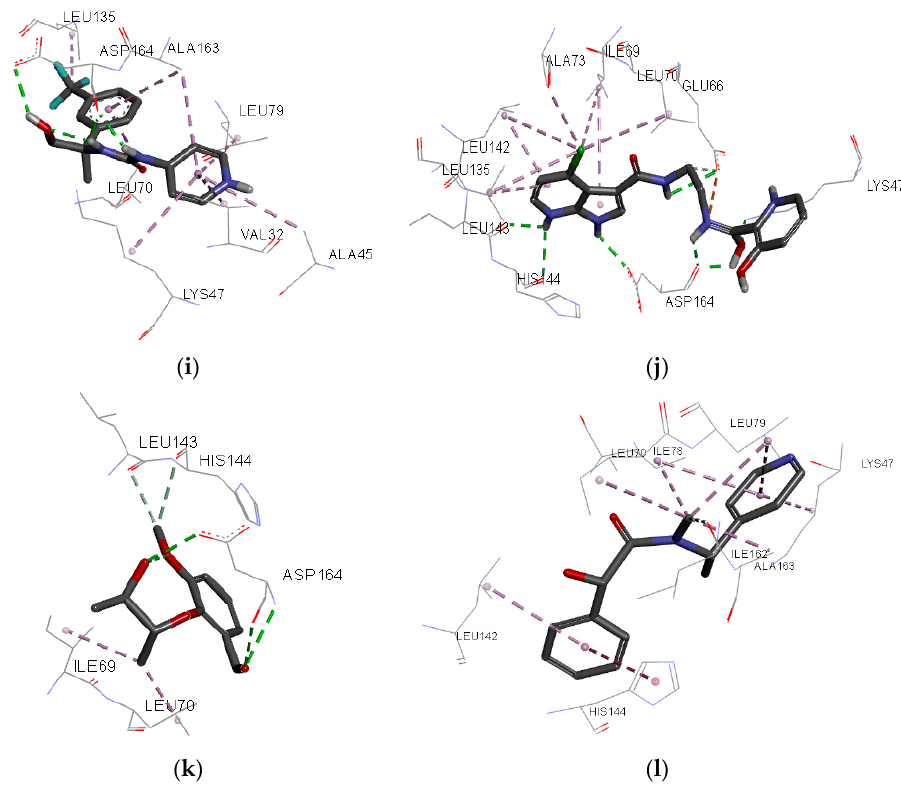
Figure 7. Individual net of interactions and contacts between RIPK2 (from PDB ID 4C8B) and the following compounds: ( a ) ZINC90174766 ; ( b ) ZINC91725665 ; ( c ) ZINC69349685 ; ( d )